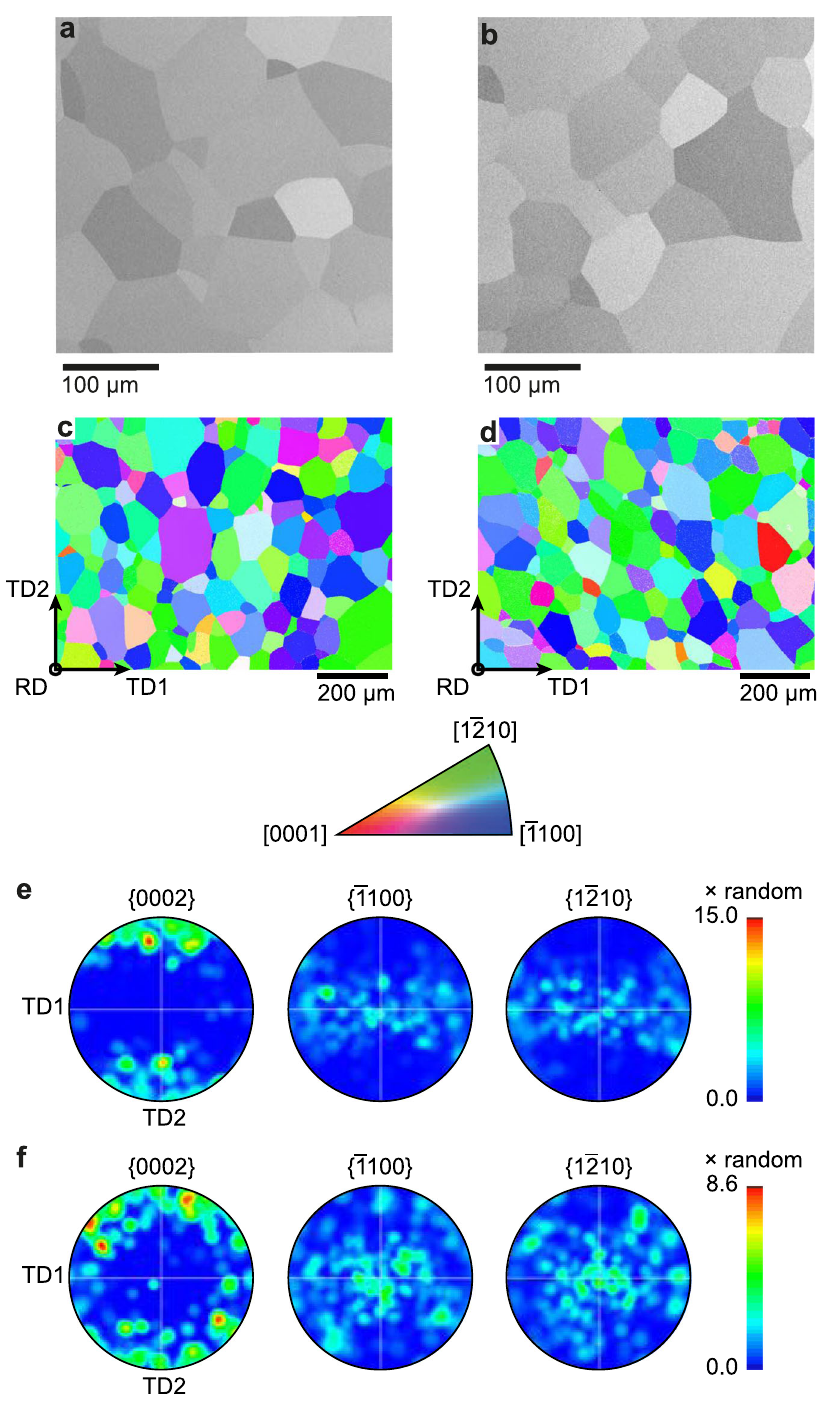
Fig. 5 | Microstructures of the model alloys. Backscatter electron images of a Ti – 7Al – 0.05O and b Ti – 7Al – 0.25O (wt.%) alloys, and c , d EBSD data displaying their respective textures. The associated pole fi gures are shown in e for Ti – 7Al – 0.05Oand( f )forTi – 7Al – 0.25O.ForEBSD,inversepole fi guremapsarewith respect to the rolling direction of the bar. The rolling direction was parallel to